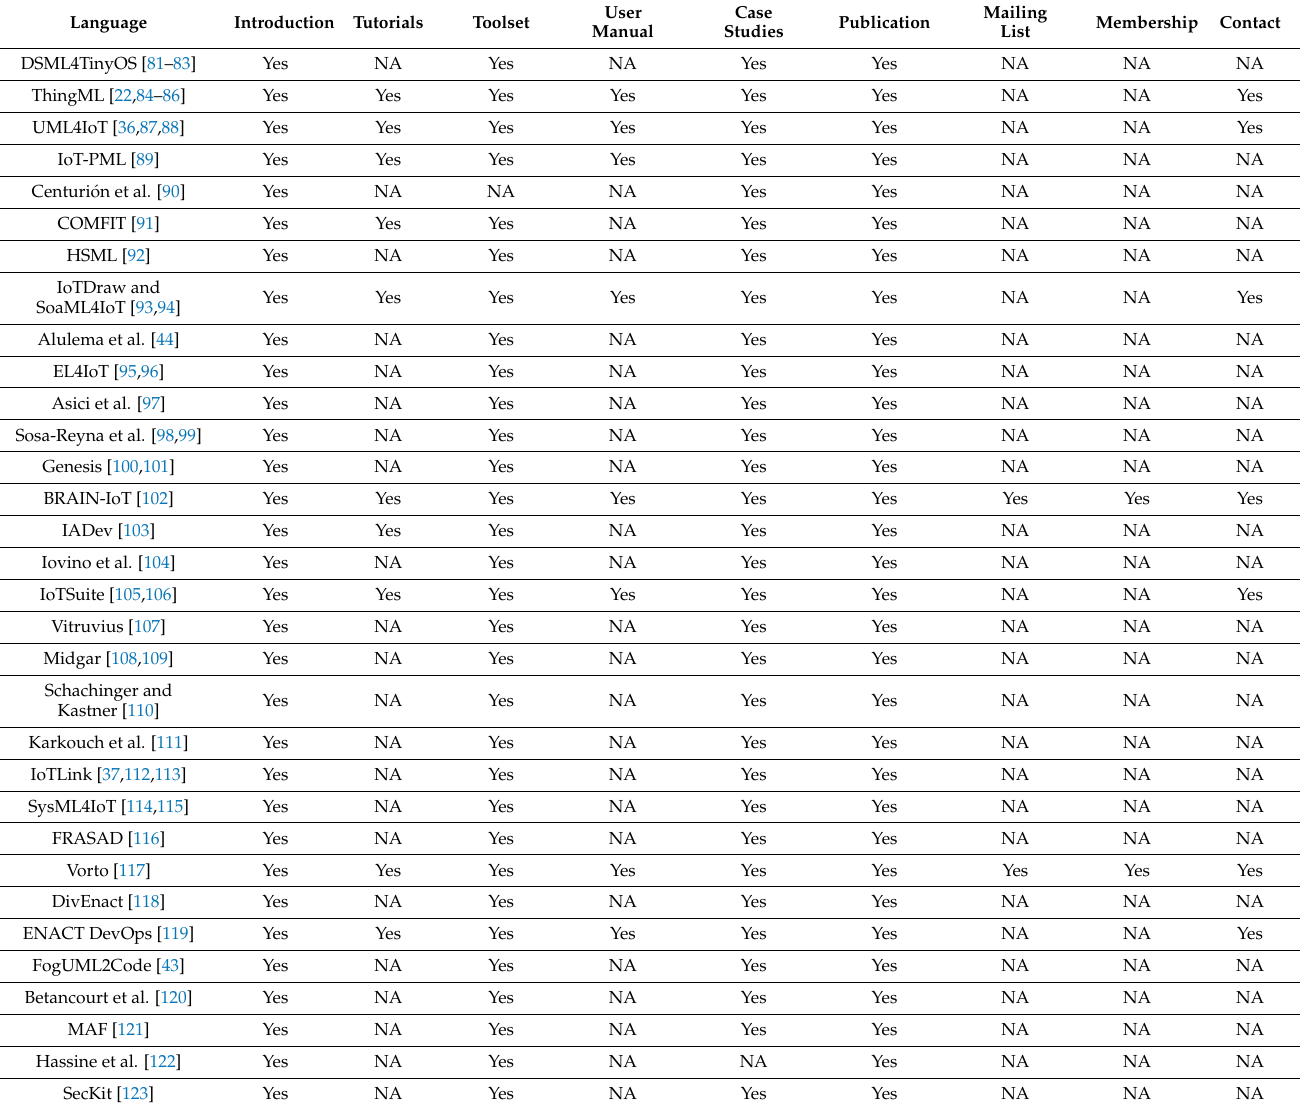
Table 10. The modeling languages for IoT that support the knowledge management